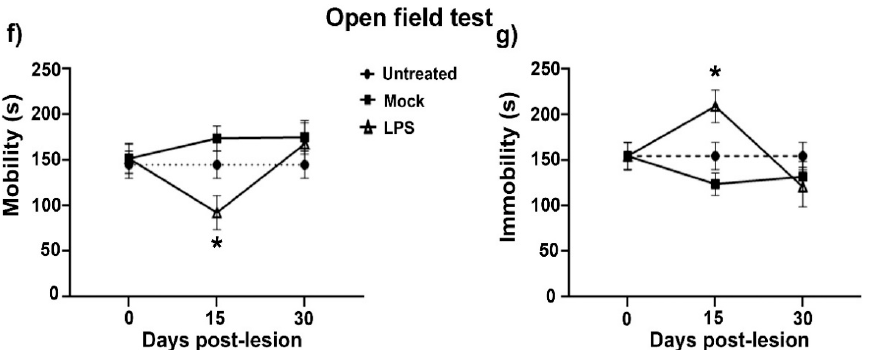
Figure 9. LPS intranigral injection elicits motor behavior and sensorimotor deficits on days 15 and 30 post-injection. Rats were evaluated with the beam test to measure ( a ) the travel time and ( b ) the number of errors per step. ( c ) The use of forelimbs was measured with the cylinder test to ascertain motor asymmetry. The sensorimotor deficit was assessed through the vibrissae-evoked response in the ipsilateral forelimb placing ( d ) and contralateral forelimb placing ( e ). Locomotor activity was quantified using the open field test by mobility time ( f ) and immobility time ( g ). Data are expressed as the mean ± SEM ( n = 6 independent rats per time point and experimental condition). The asterisk (*) compares LPS groups with the Mock and Ut groups. One-way ANOVA and post hoc Tukey tests, p <